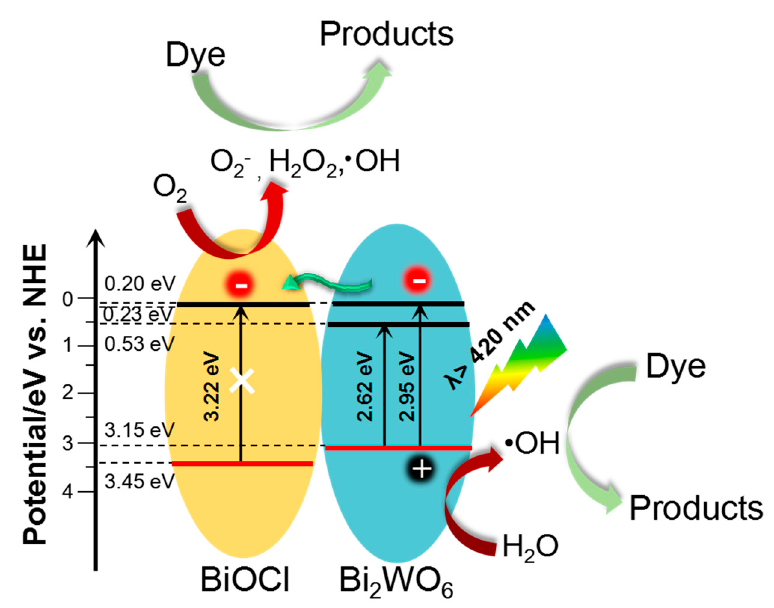
Figure 7. Schematic diagram of the charge–transfer mechanism of BiOCl/Bi 2 WO 6 hybrids under visible light irradiation.